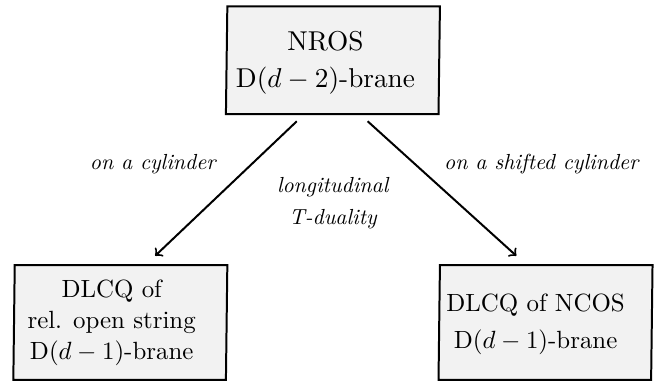
Figure 1 . Longitudinal T-duality on a regular (shifted) cylinder relates NROS on a D( d − 2 )-brane to the DLCQ of relativistic (noncommutative) open string theory on a spacetime-filling D( d − 1 )- brane. Both of the dual theories on the lower left and right corners have a compact lightlike